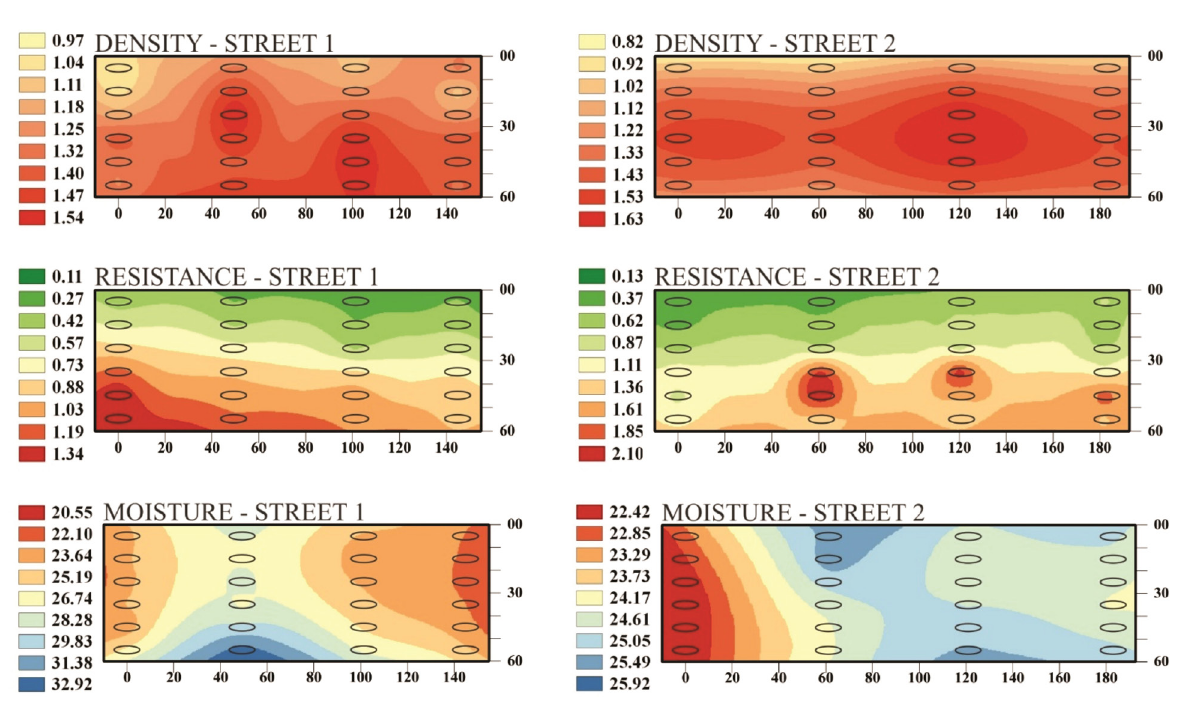
Figure 4. Spatial variability of soil physical properties BD, PR and GM, in longitudinal profiles, interpolated for streets 1 and 2, using ordinary kriging method whit OLS fitting, aggregated with visual recognition of the spherical models (Figures 2 and